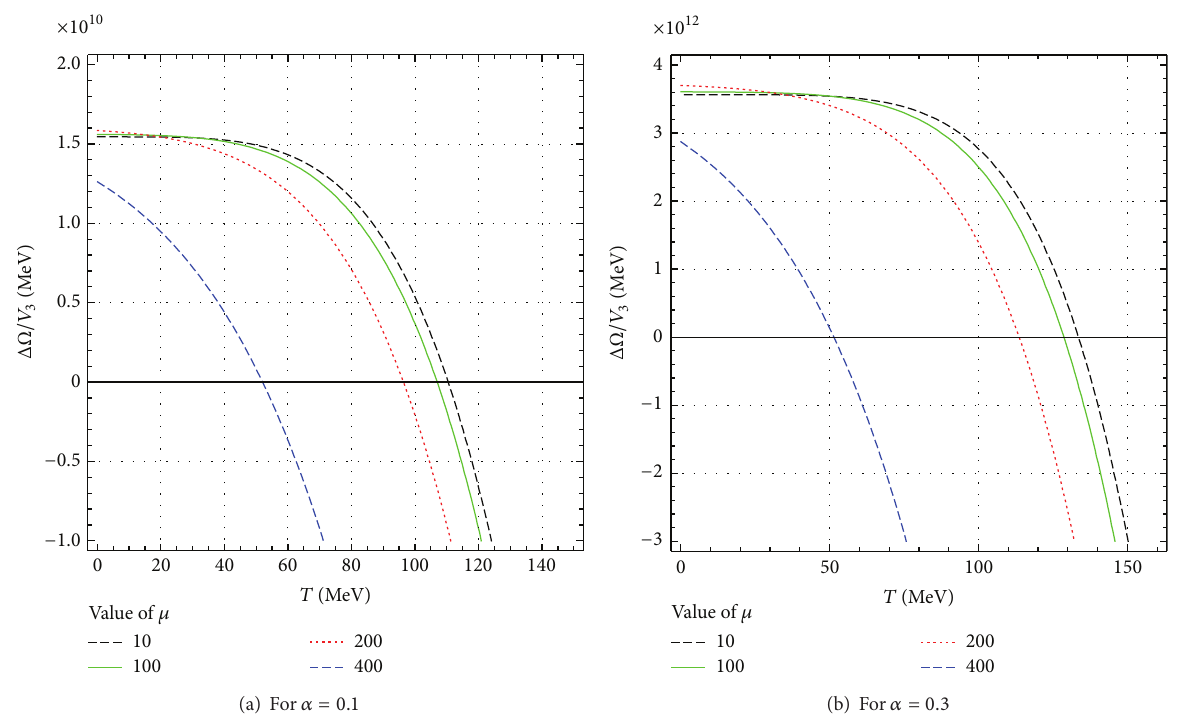
Figure 1: Grand potential versus temperature at various values of 𝜇 for constant 𝛼